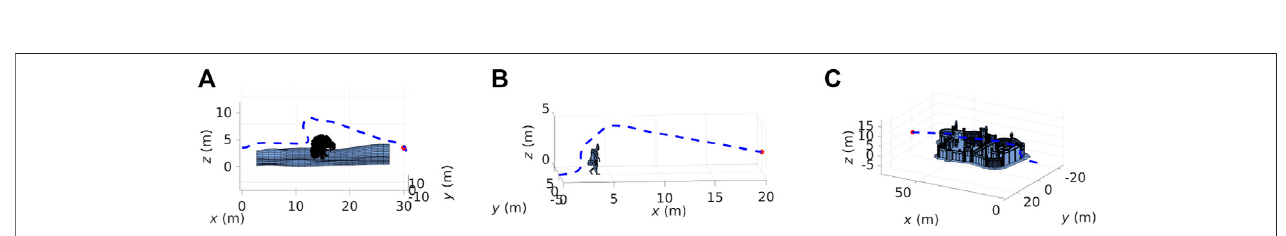
FIGURE 9 | The robot ’ s trajectory using the magnetic- fi eld-inspired navigation with geometric control in different environments populated with (A) a tree, (B) a human, and (C) a castle.